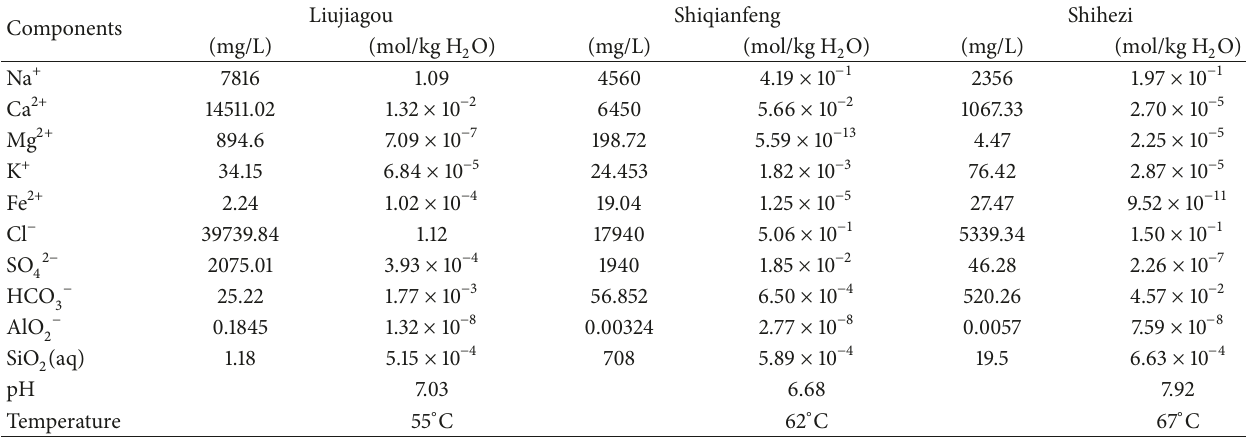
Table 2: Aqueous concentrations of in situ water [26, 27, 32] and initial aqueous concentrations for simulations.